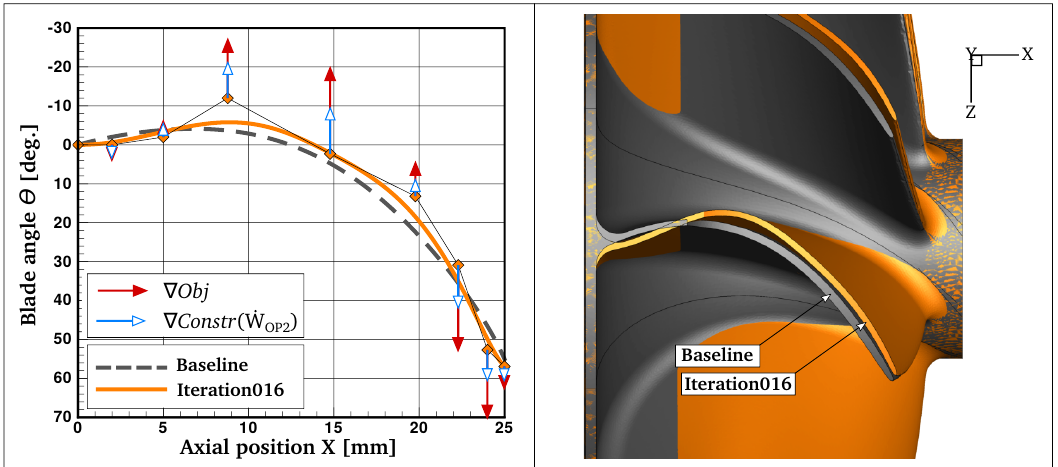
Figure 13. Comparison of blade angle θ -distribution of the baseline and optimized geometry ( left ). The arrows show the design gradients of the weighted objective function (Equation (11)) and power constraint function at operating point OP2. Comparison of the blade shapes ( right